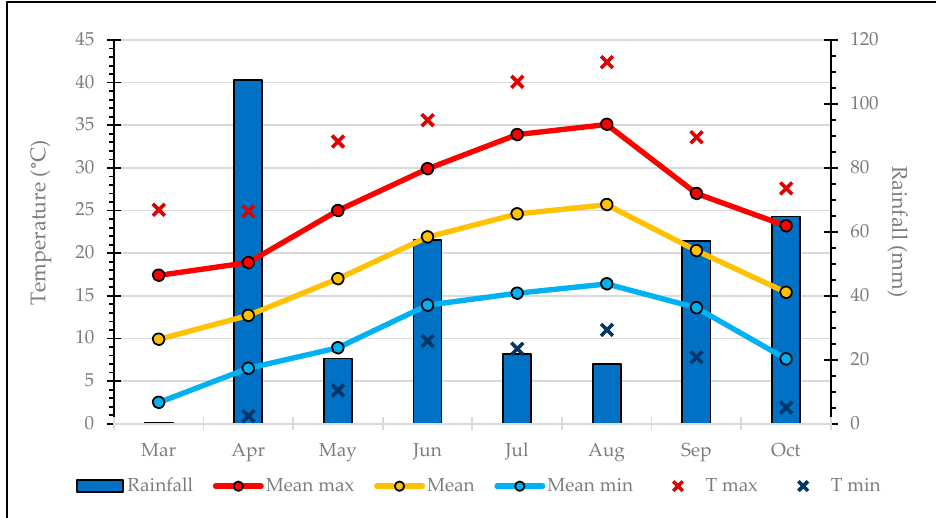
Figure 1. Climograph of Alcalá de Henares from March to October 2021.